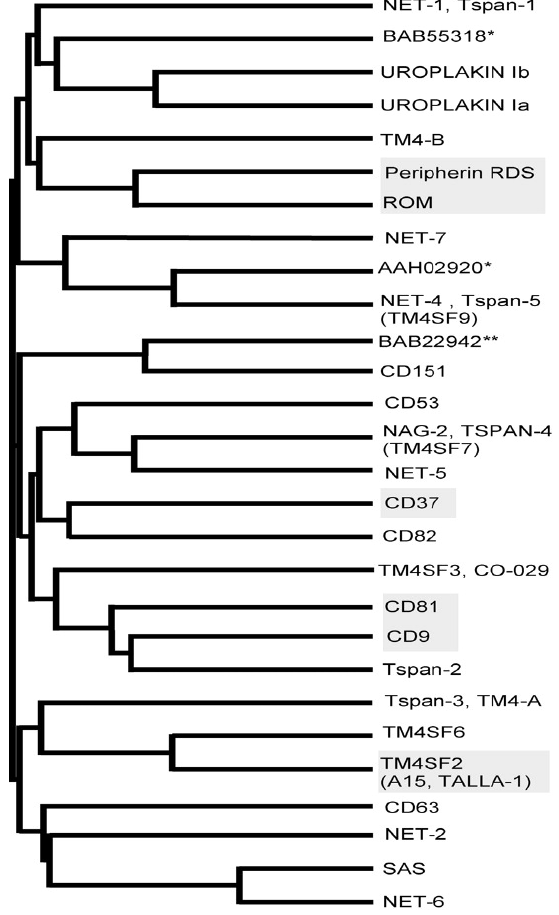
Figure 1. Mammalian tetraspanin family. The 28 family tetraspanin members. The shaded tetraspanins represent the ones that are either mutated in humans or deleted in mice. Reprinted with permission from [7]. * Accession number – no other names available. ** Murine sequence.